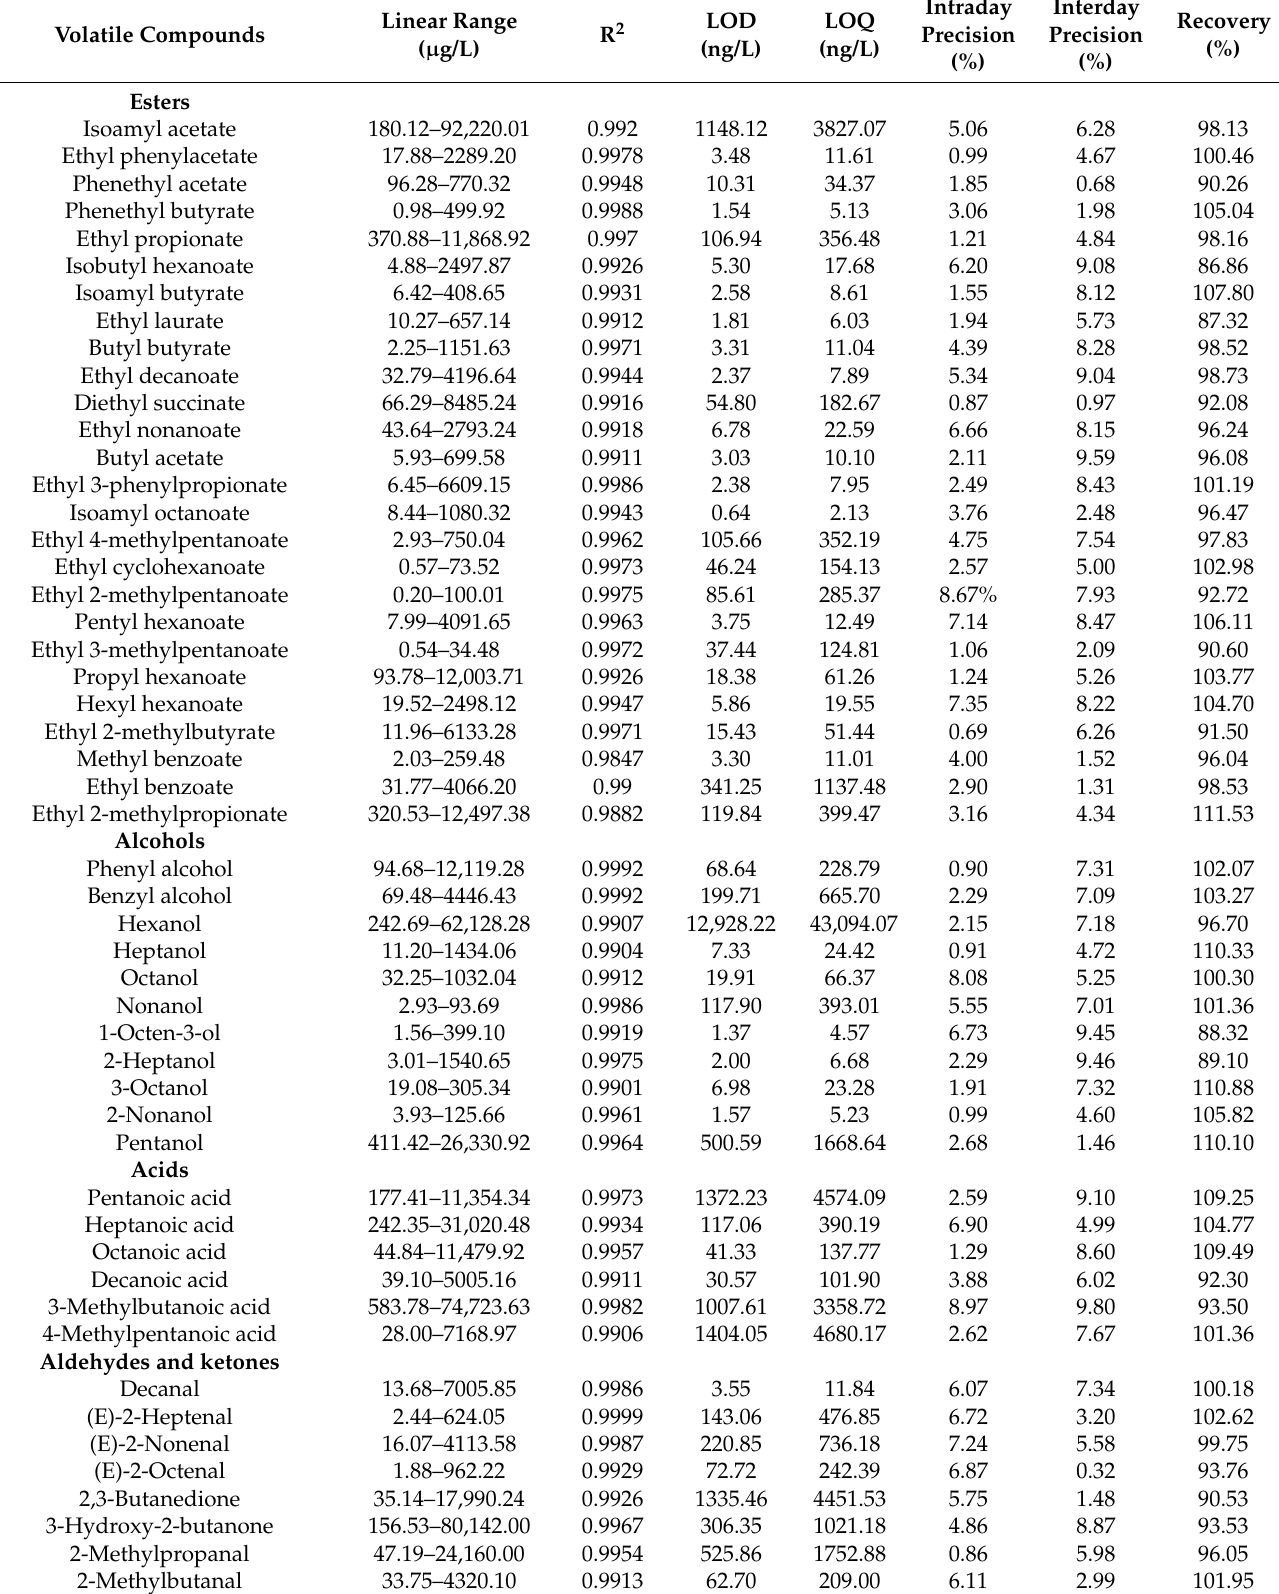
Table 2. Liner range, coefficients of determination, limits of quantification (LOQ), limits of detection (LOD), precision, and recovery results of the proposed